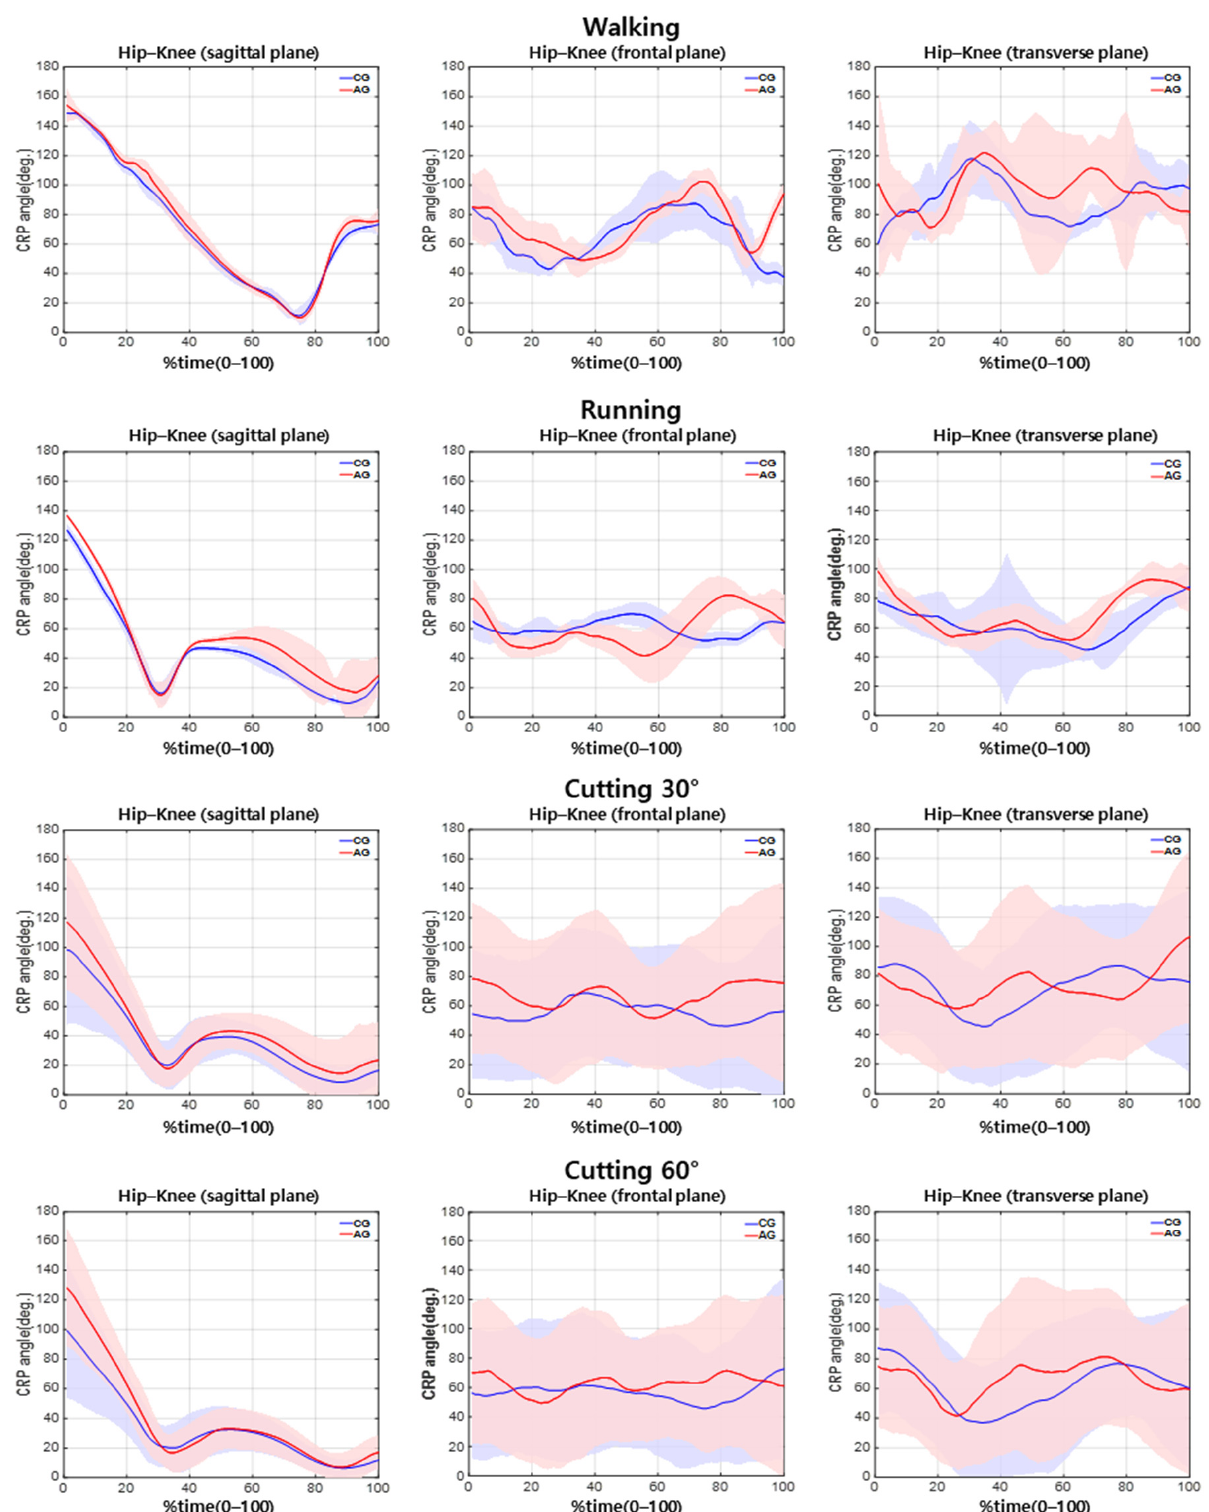
Figure 4. Ensemble average of CRP between hip–knee joint according to difficulty of